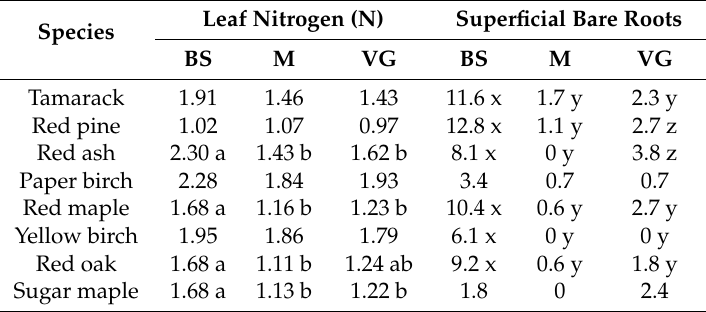
Table 4. Vegetation treatment effects on leaf nitrogen (N) and rooting (%).